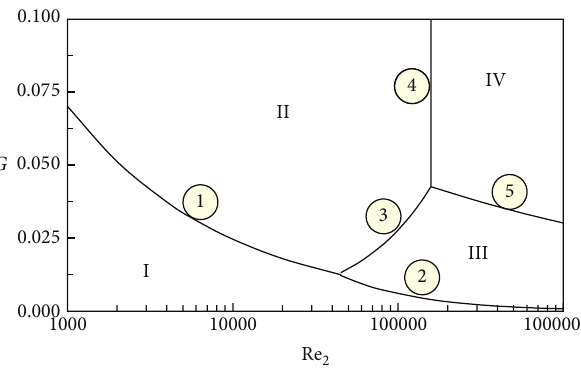
Figure 8: Disk friction flow regimes